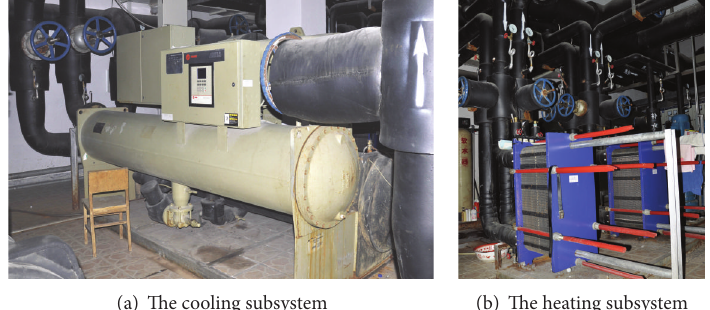
Figure 1: The combined heating and cooling system.